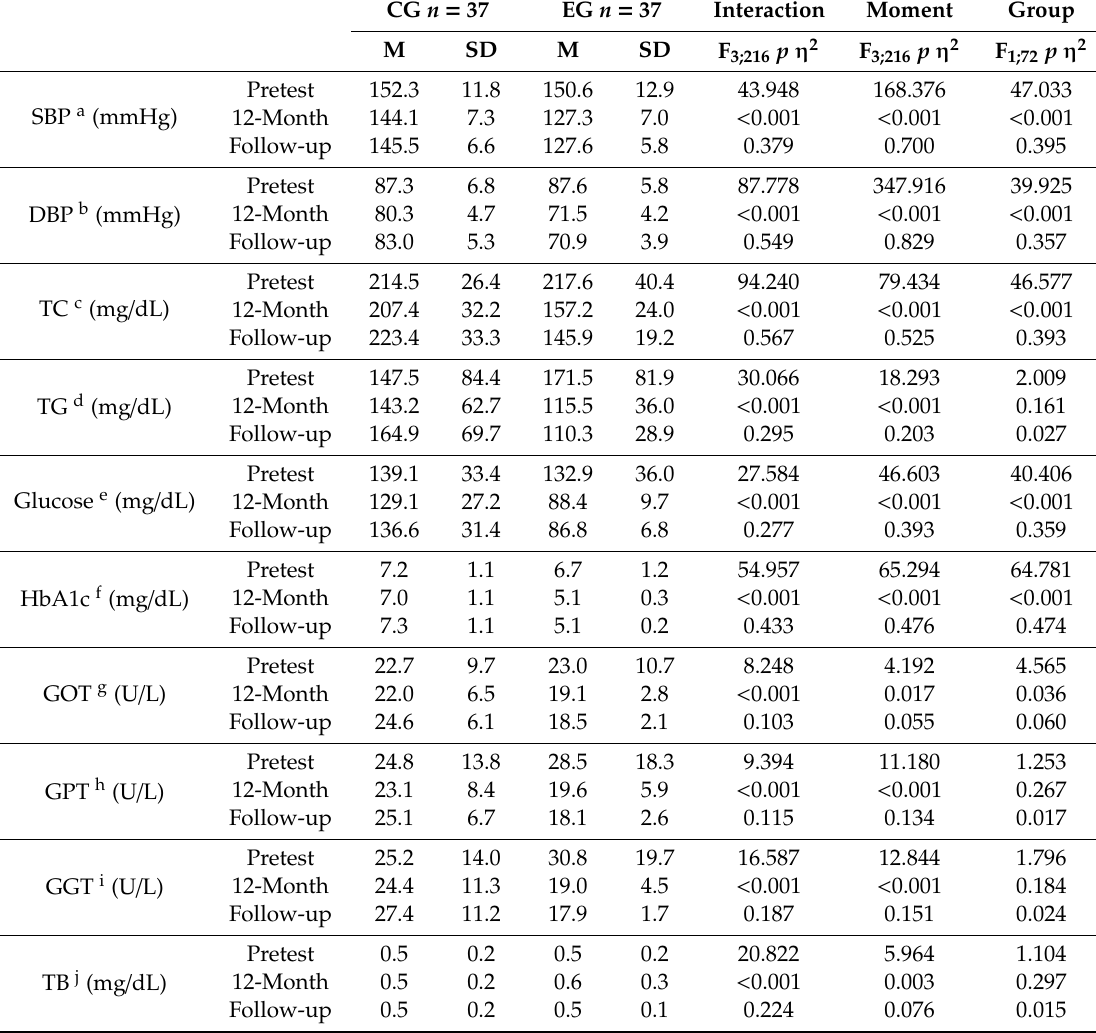
Table 3. E ff ects of intervention on metabolic